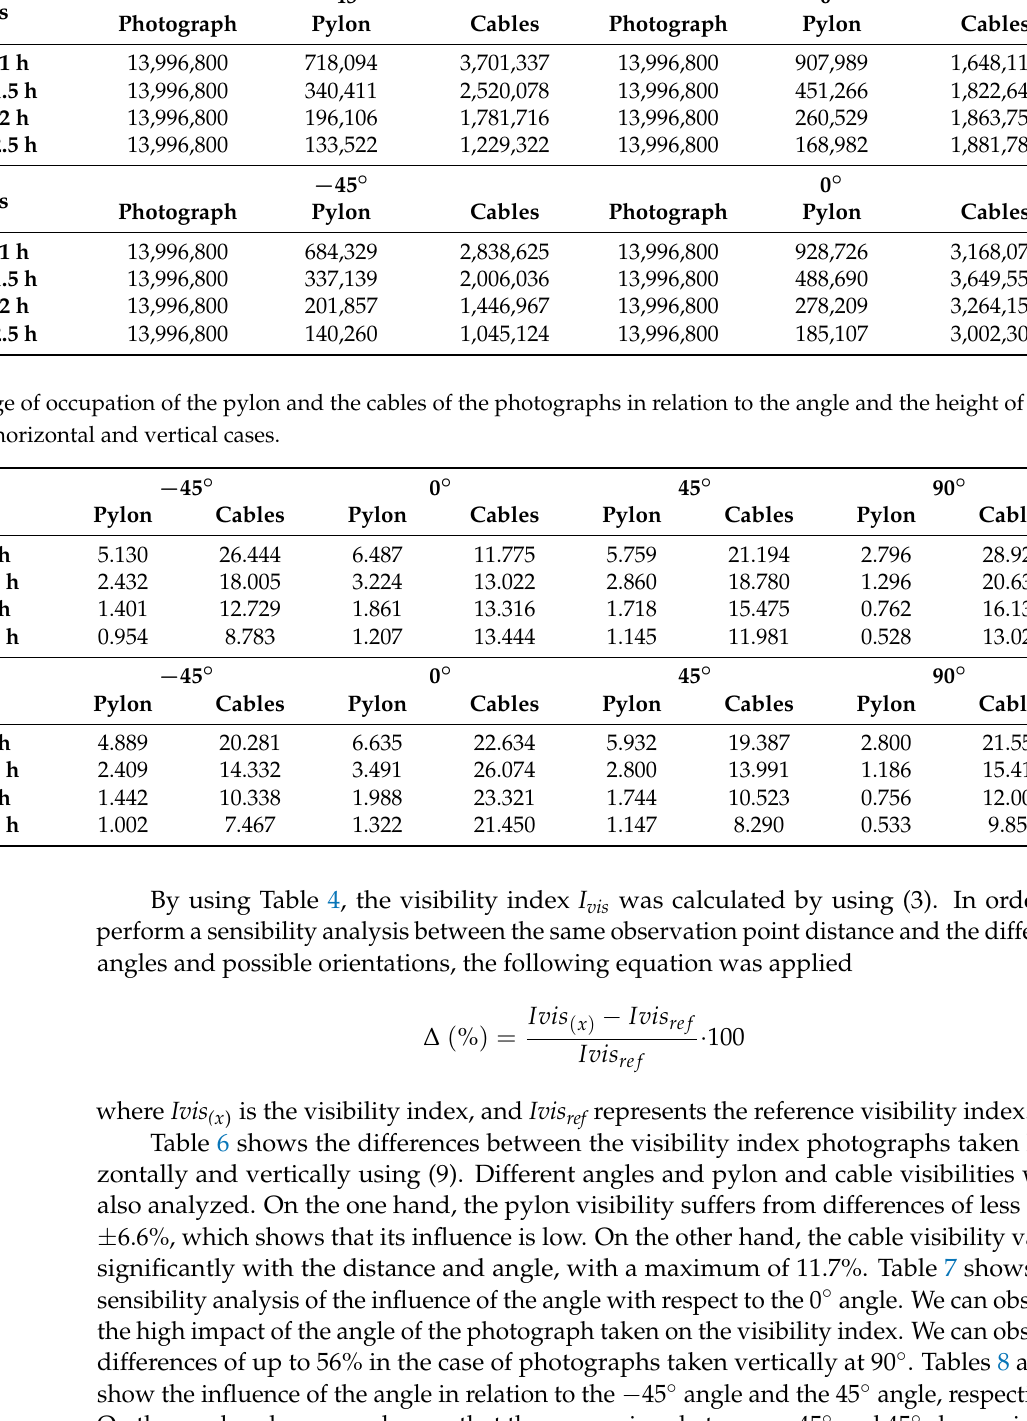
Table 4. Example of the values of pixels obtained by the analysis of the photographs for 0 ◦ and − 45 ◦ for the horizontal and vertical cases.